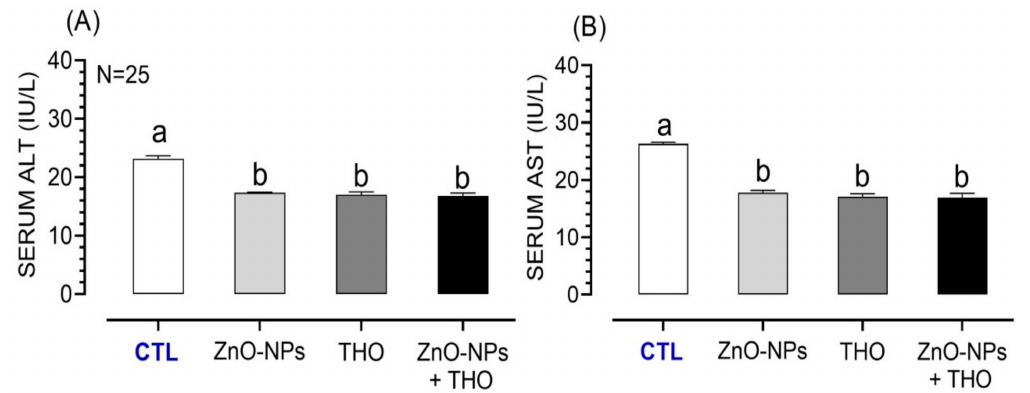
Figure 3. Serum concentrations of liver markers; alanine amino transferase (ALT) ( A ) and aspartate amino transferase (AST) ( B ) in response to supplementation of ZnO-NPs, THO, combined doses of both ZnO-NPs + THO, or a control (CTL) in male Californian rabbits. Letters on the bars a, b denote the significant di ff erence between the di ff erent treatments ( p <